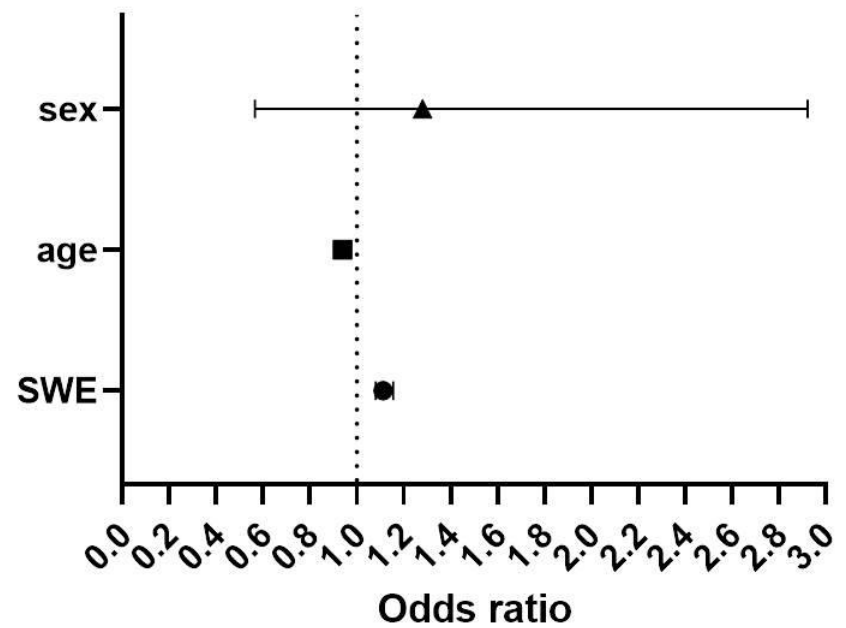
Figure 1. Likelihood of occurrence of whiplash injury in response to age, gender, and SWE. probability of injury ( % ) = 1 1 + e 4.326 − 0.017 · SWE − 0.248 · sex + 0.063 · age . Sex = 0 for male and 1 for female, SWE should be expressed in kPa and age in years.